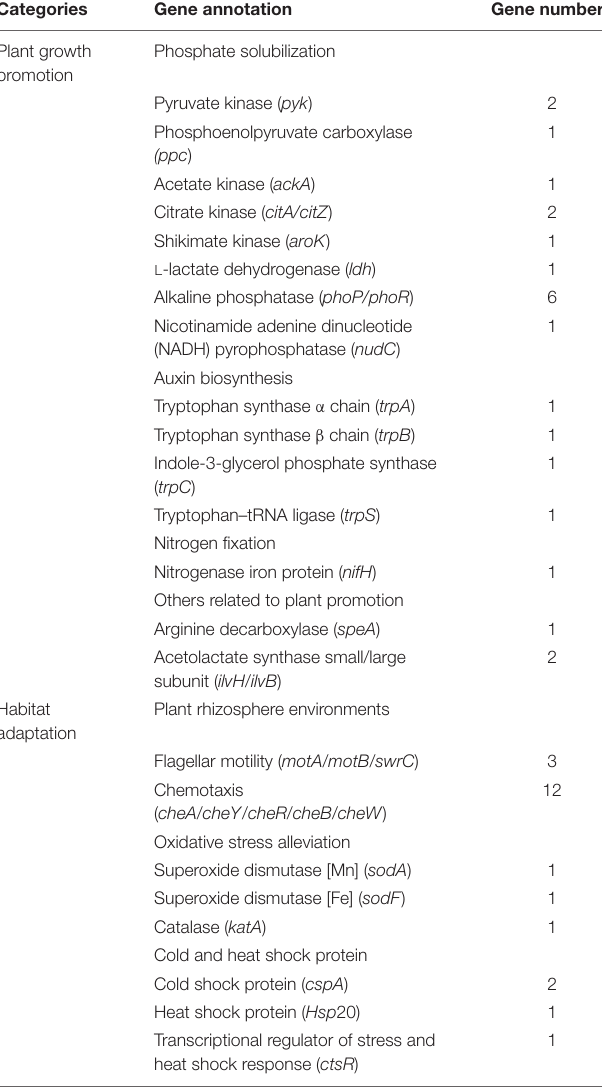
TABLE 2 | Putative gene identified in LC-T2 T genome related to plant associated lifestyle and habitat